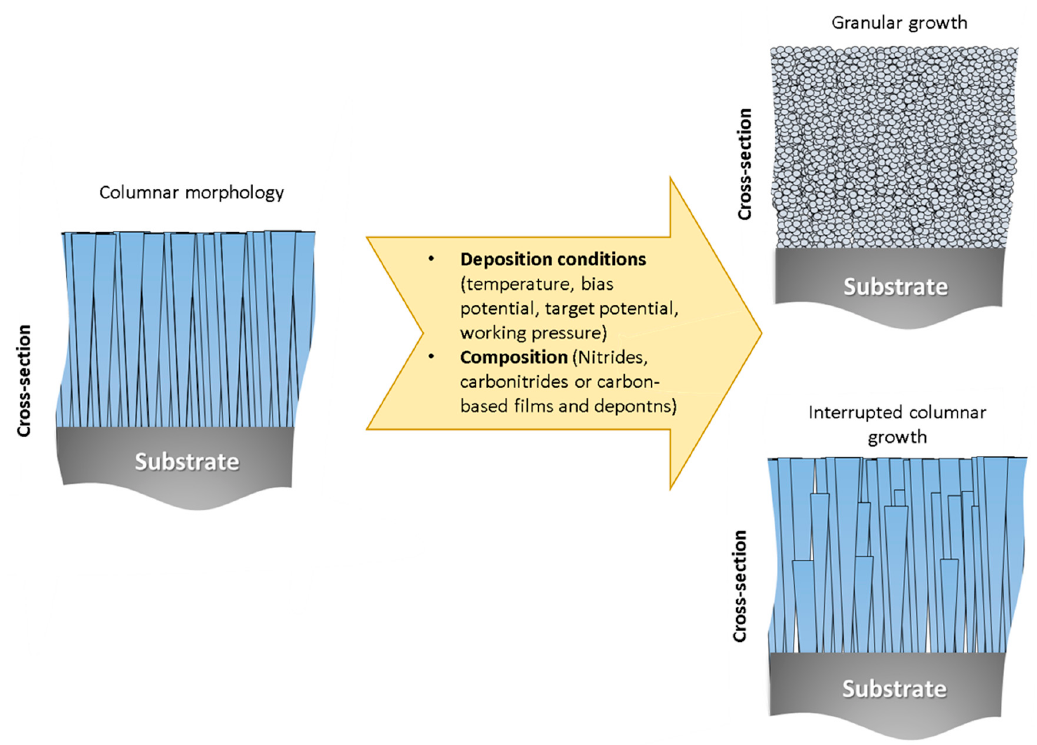
Figure 1. Morphological changes due to processing and/or compositional changes.